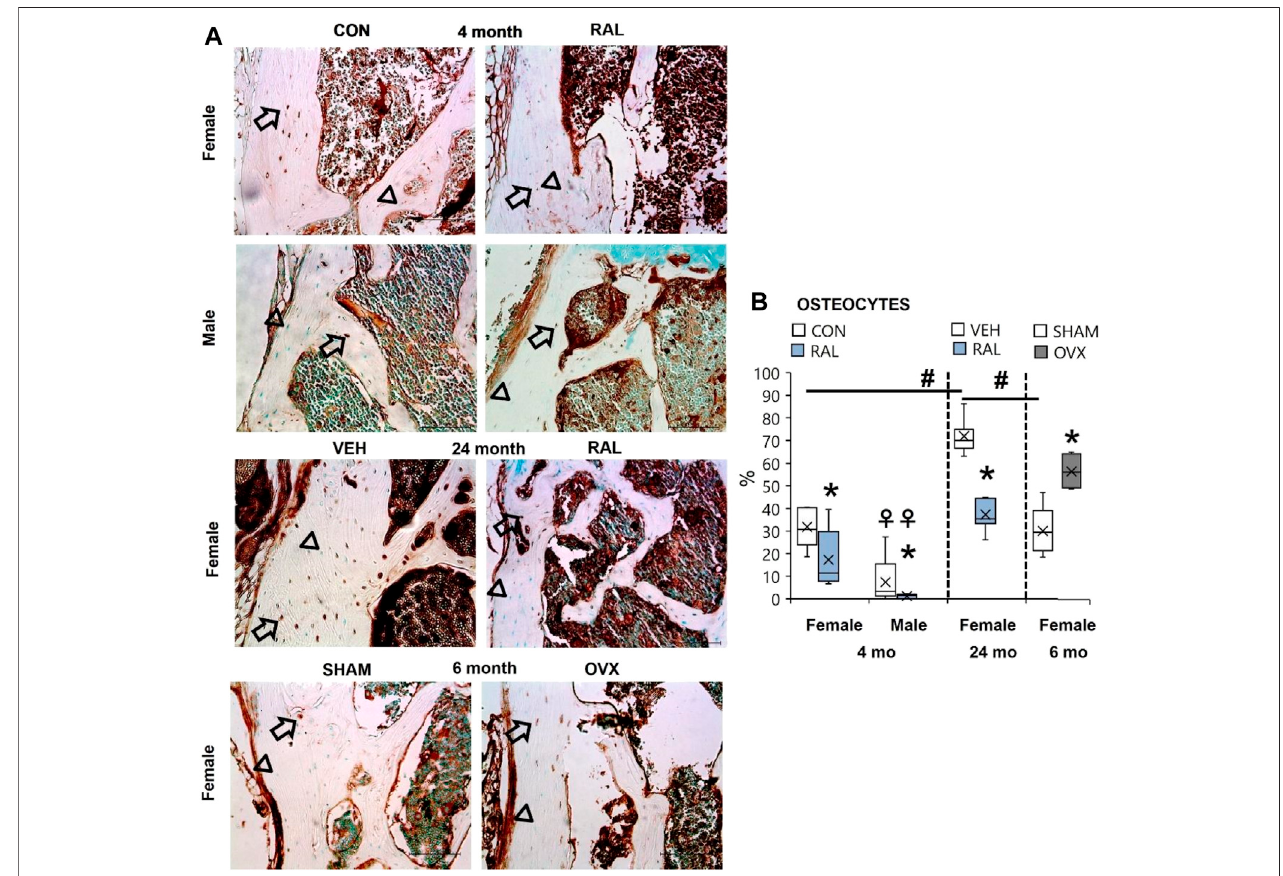
FIGURE 8 | Age, biological sex, OVX, and raloxifene regulated the number of substance P-expressing osteocytes in lumbar vertebrae. (A) Substance P immunohistochemical staining (arrow: presence of stain; arrowhead: absence of stain) of young-adult (4 months), OVX (6 months), and old (24 months) mice. (B) Percentage of substance P-expressing osteocytes in L6 vertebra. Data are represented as box plots with mean marked as cross (x), 25/75% deviation lines, and maximum/minimum whiskers. *: Control (CON, n = 5/sex/group) vs. raloxifene (RAL); R: CON vs. RAL; S: male vs. female; RxS: interaction; vehicle (VEH, n = 8/ group) vs. RAL, SHAM ( n = 4 – 5/group) vs. ovariectomized (OVX); # : aging effect (4 months vs. 6 months vs. 24 months); \ : sex effect (male vs. female), p < 0.05. Scale: 100 μ